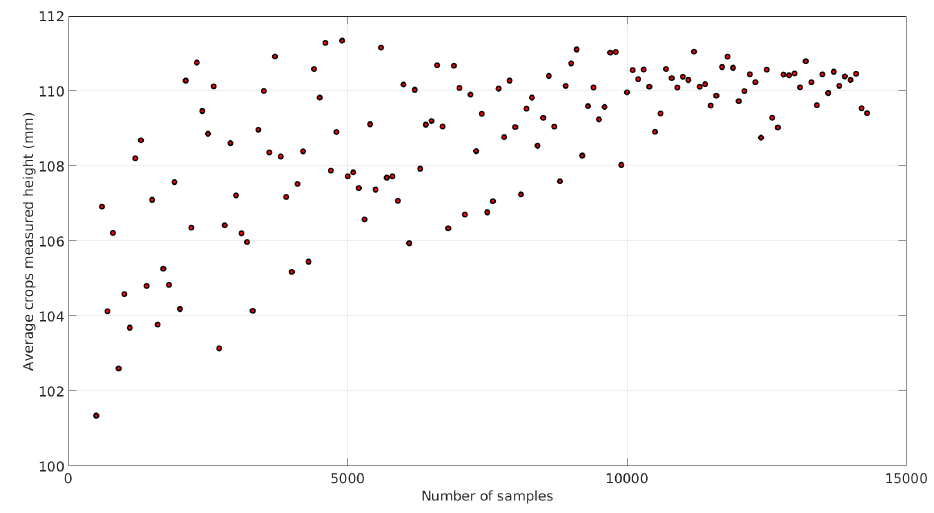
Figure 10. Subsampled scanning results, mean